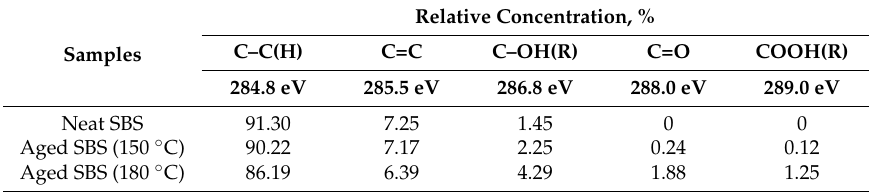
Table 2. Effect of aging temperature on the relative concentration of carbon-related groups of SBS.